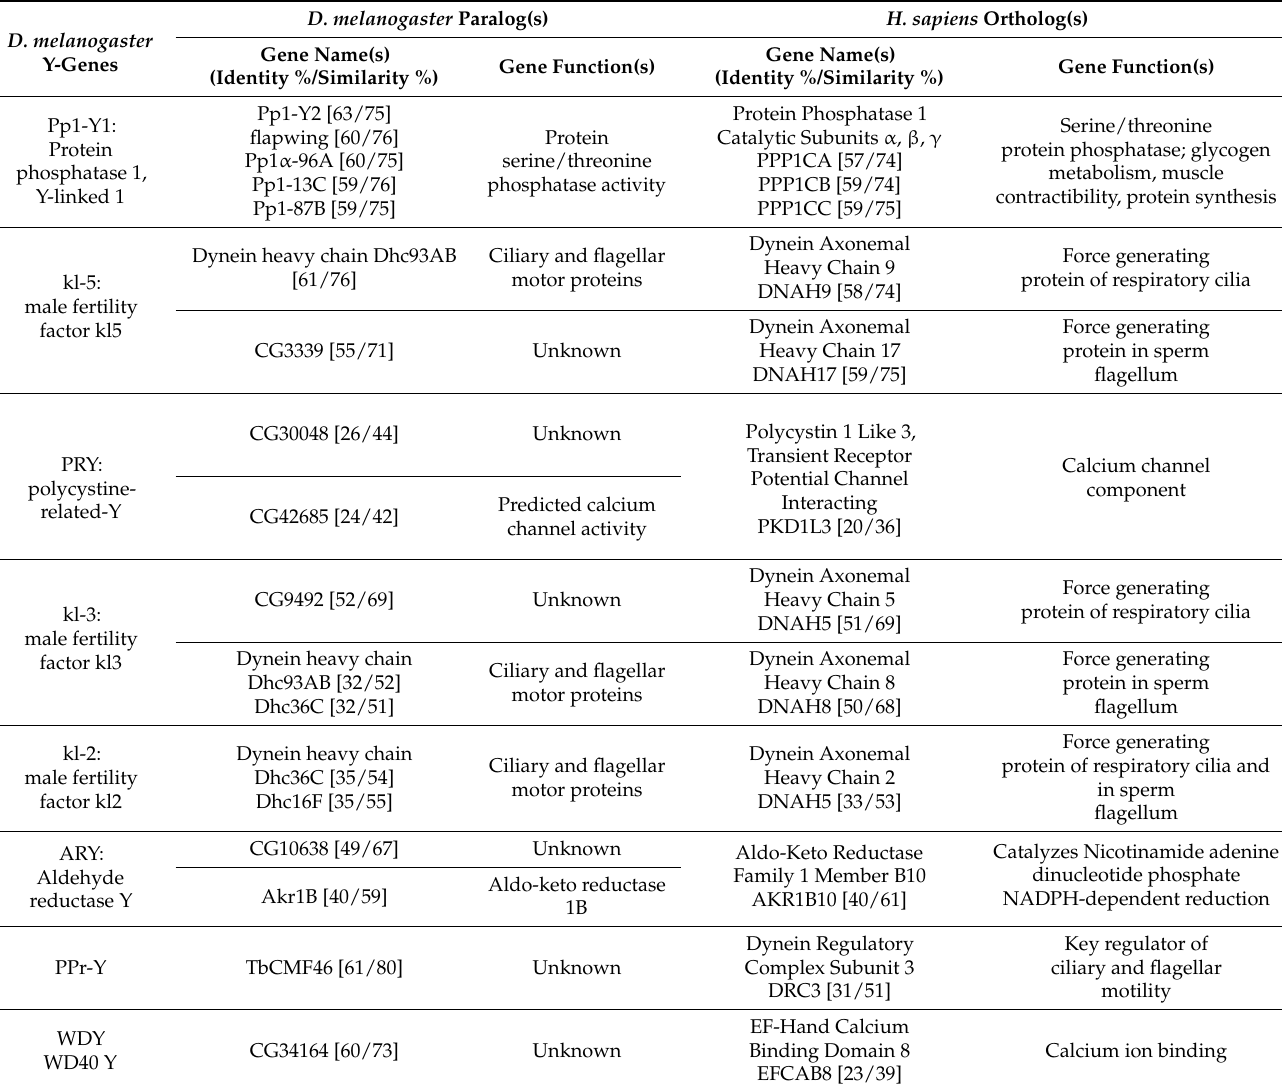
Table 1. Paralogs and orthologs of Drosophila melanogaster Y chromosome genes. For fly and human genes, the percentage of identities and similarity to Y-genes is shown, as well as gene